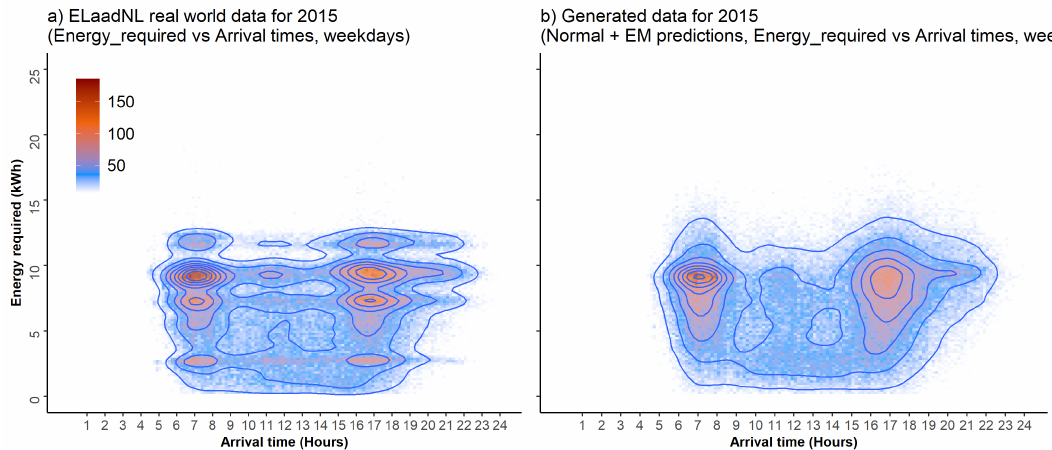
Figure 9. Density plots for required energy (2015, weekdays). Generated data represent sampled energy requirements for real-world EV arrivals. Each point represents a bin (10 min by 0.16 kWh), and is colored based the number of EV sessions in the bin (bins with less than 5 arrivals were not plotted to keep the graph